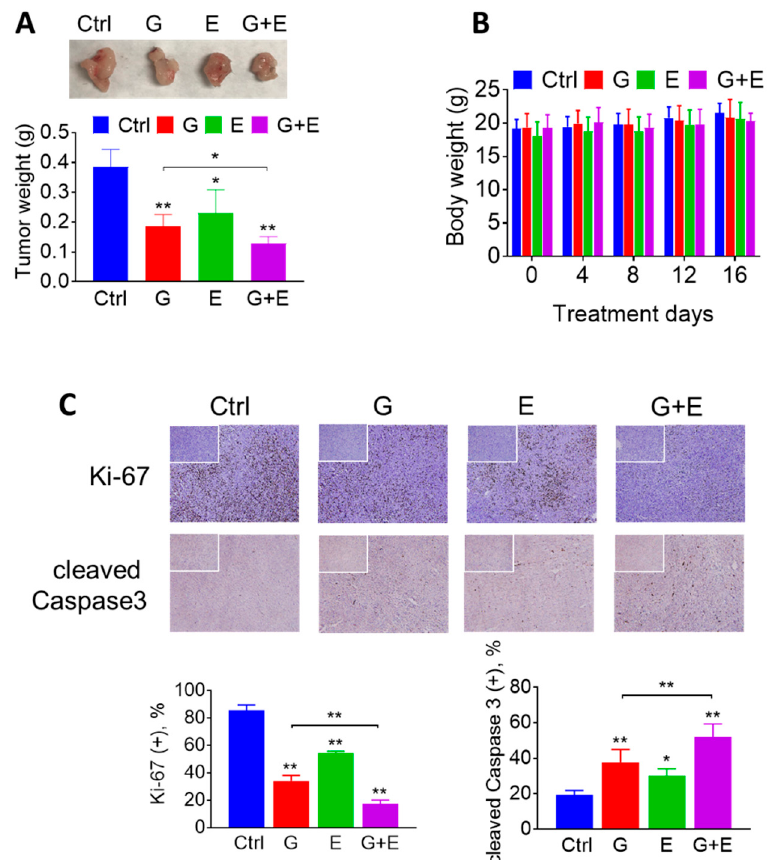
Figure 5. EGCG enhances the anticancer effect of gemcitabine in pancreatic cancer xenografts. ( A